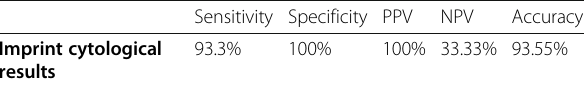
Table 4 Receiver operating characteristic (ROC) curve of imprint cytological results in the bronchoscopic group Sensitivity Specificity PPV NPV